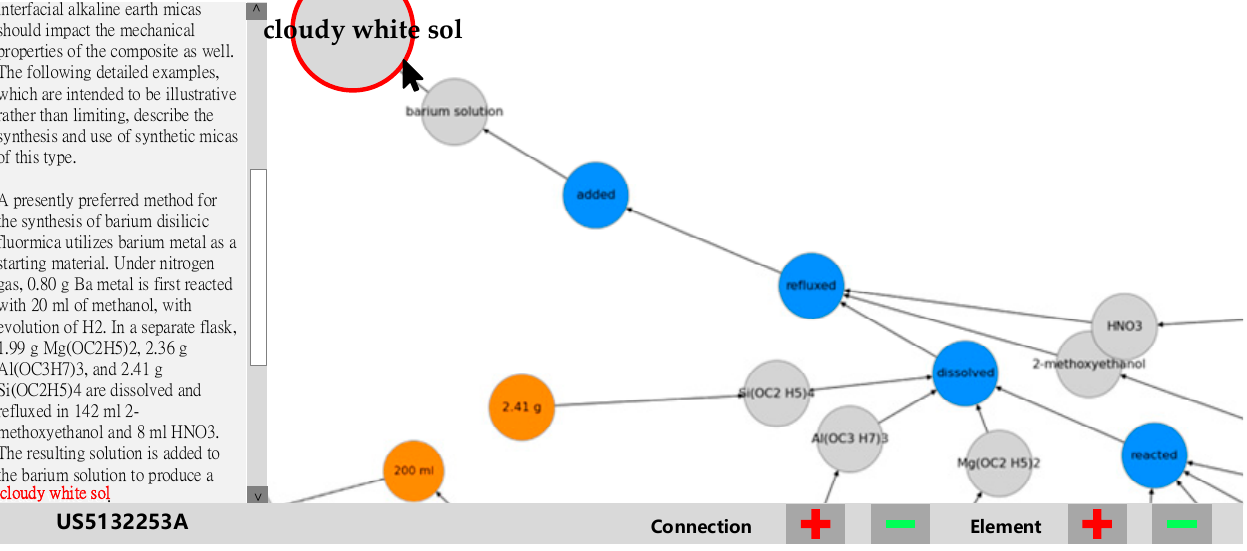
Figure 8. A schematic process graph sample created for chemical utility patent US5132253A.